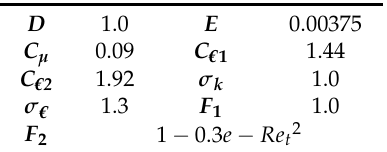
Table 5. Simulation